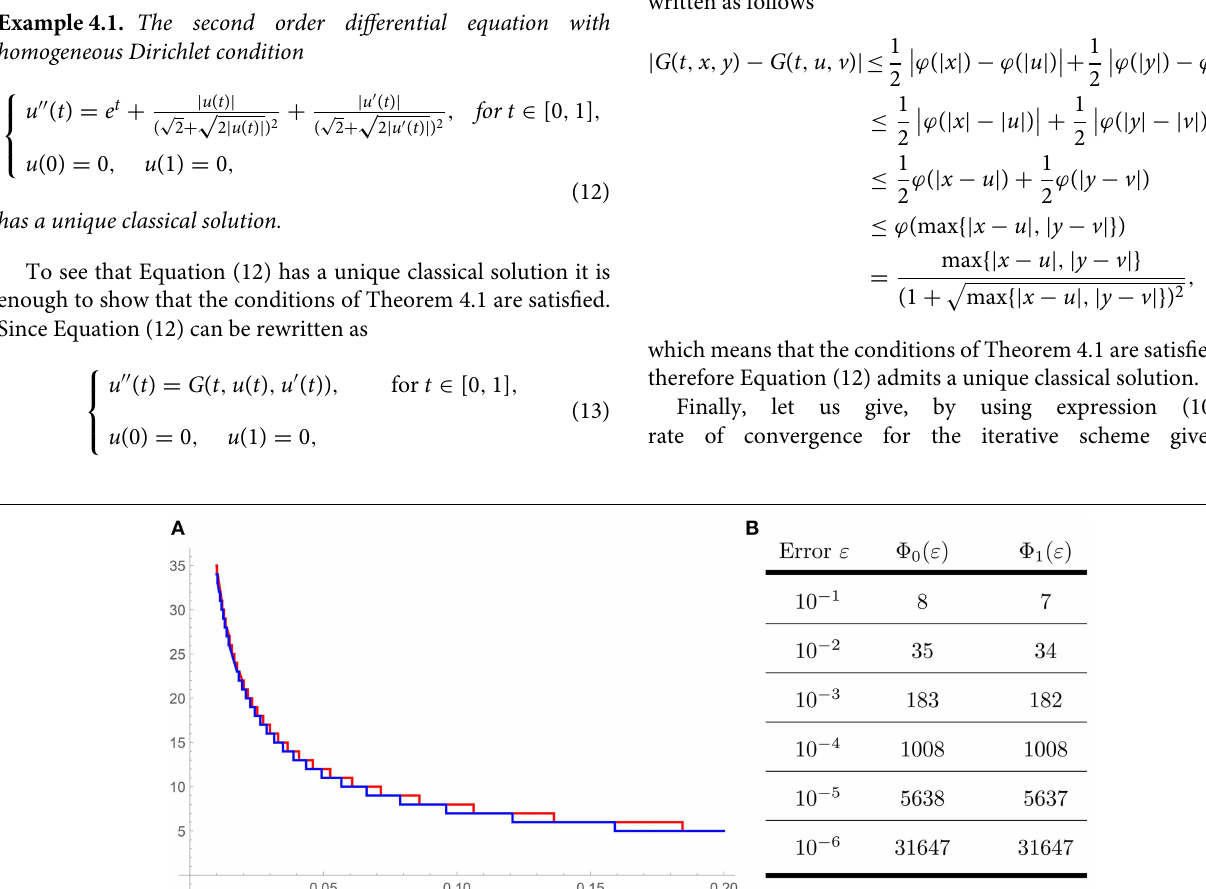
0 and blue line is the ratio for the starting point u 1 = t 2 t = −